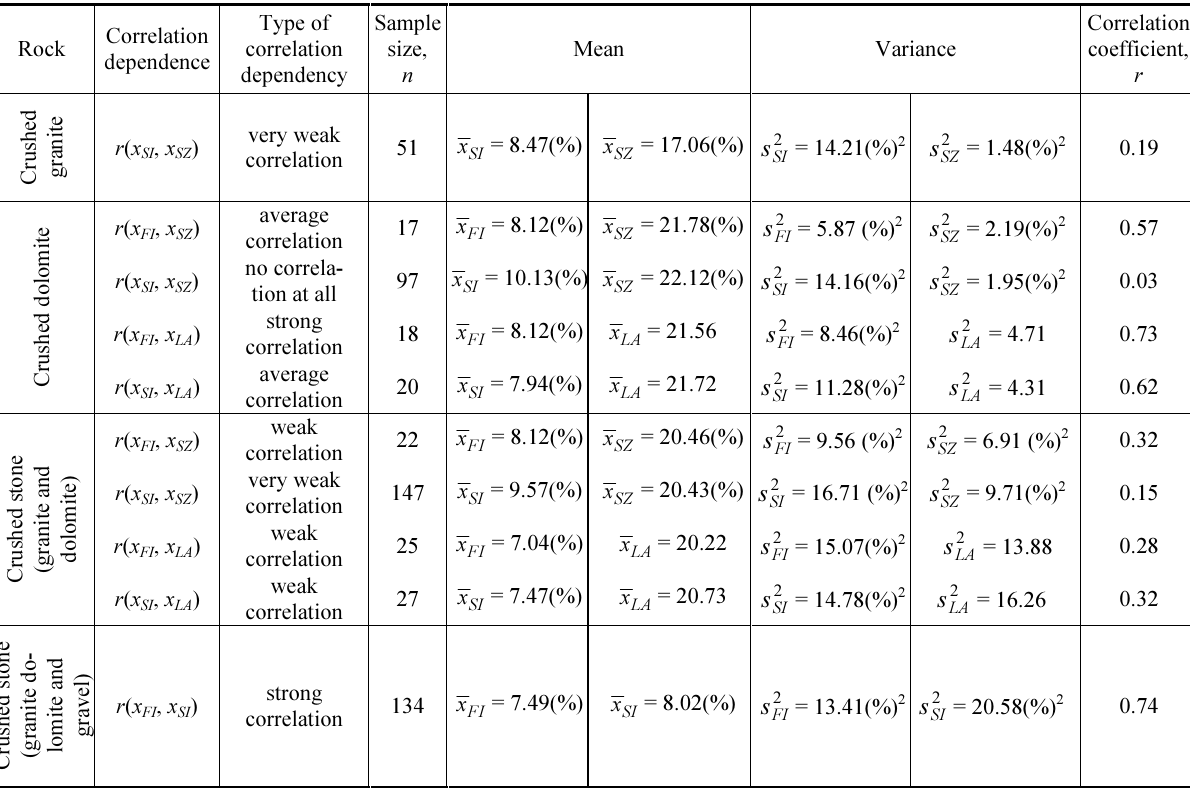
Table 6. Summary of correlation dependences between mechanical, physical, and geometric indexes of the analysed aggregate strains (granite dolomite and gravel)